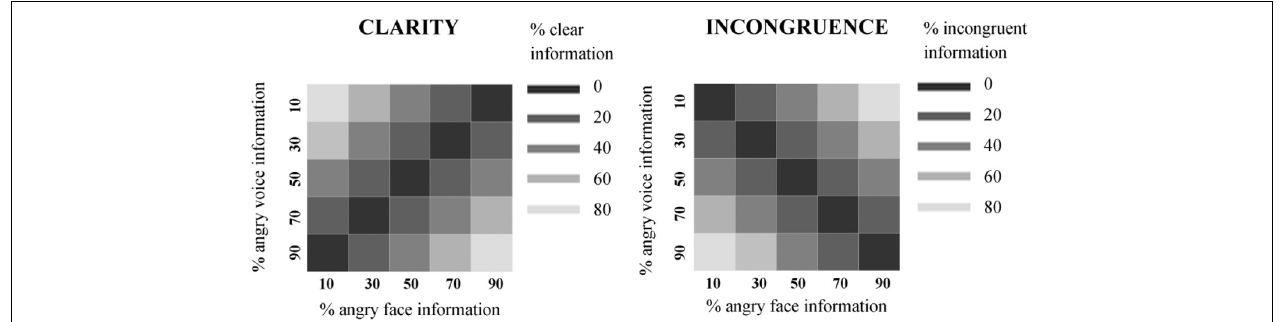
FIGURE 2 | Clarity and incongruence values assigned to face-voice stimuli. Left: Clarity values. Each square in the grid represents one audiovisual stimulus. The horizontal value indicates the percentage of angry face information contained in the stimulus, and the vertical value represents the percentage of angry voice information contained in the stimulus. The color represents the clarity value of the stimulus (darkest = lowest clarity value = unclear combined information in the stimulus; lightest = highest clarity value = clear combined information in the stimulus). Right :